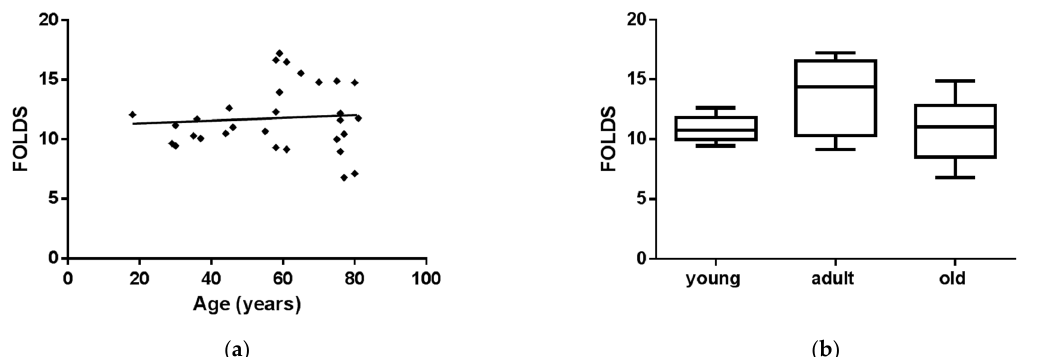
Figure 3. MiR-126-3p levels in sEVs of FD patients are not modulated by aging. Scatterplots showing relative miR-126-3p expression according to age in FD patients ( a ); miR-126-3p levels variation in sEVs of FD patients grouped in age class. Box and Whiskers indicate median, minimum, and maximum levels of miR-126-3p in sEVs from different age class of FD patients (30) ( b ). Data were calculated by qRT-PCR and represent mean ± SD of three different experiments analyzed in triplicate. CTs (cycle thresholds) resulting from qRT-PCR analysis were normalized with mir-30a; levels were calculated with 2- Δ CT method and expressed as folds, with respect to lowest value registered. Comparison among multiple groups was analyzed by one-way analysis of variance, followed by Bonferroni’s post hoc test.